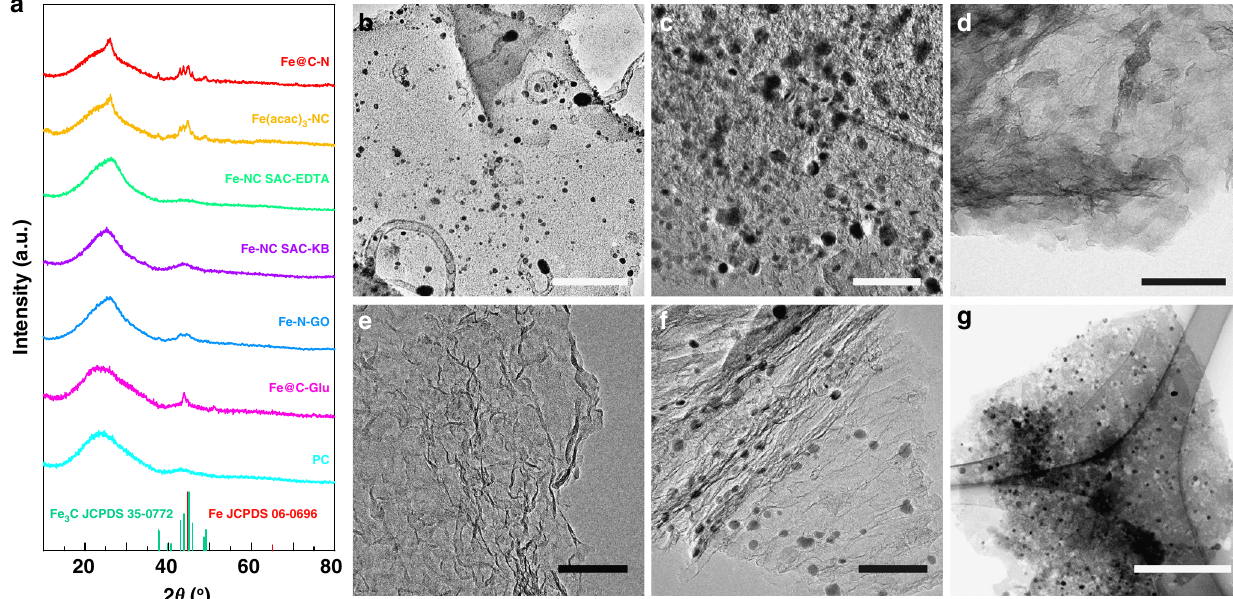
Fig. 4 Structural characterizations of control samples. a XRD patterns and b – g , TEM images of Fe@C – N ( b ), Fe(acac) 3 – NC ( c ), Fe – NC SAC – EDTA ( d ), Fe – NC SAC – KB ( e ), Fe – N – GO ( f ), and Fe@C-Glu ( g ). Scale bars: 200 nm ( b , d ); 100 nm ( c , e , f ); 500 nm ( g